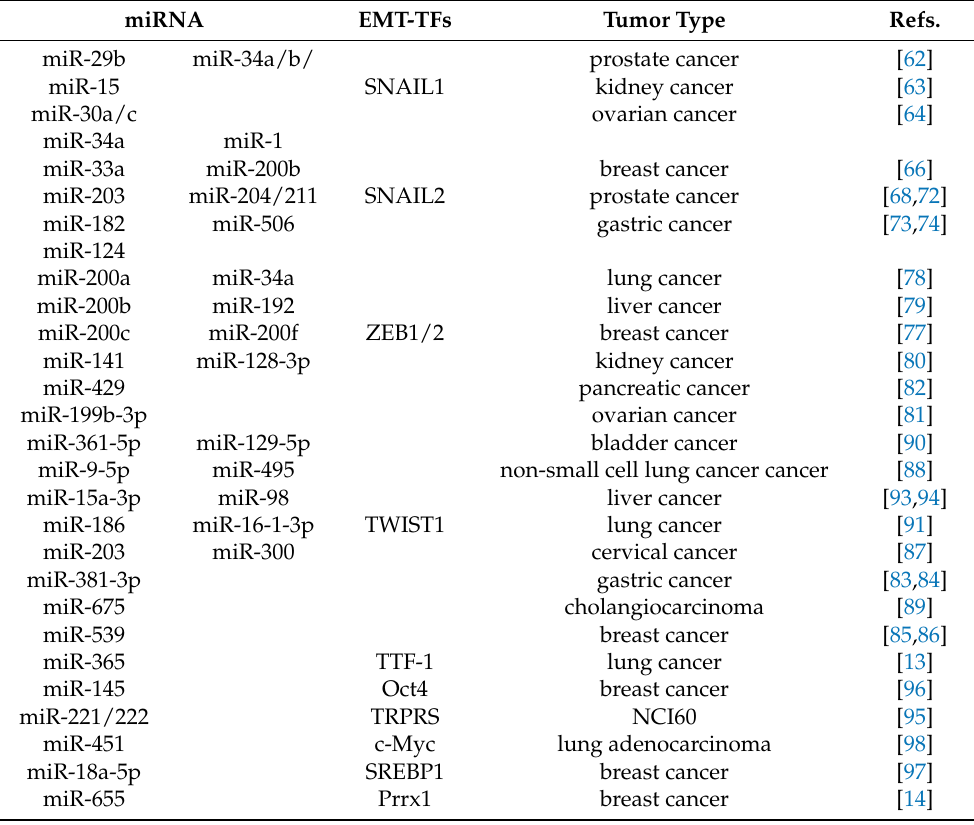
Table 1. Distinct miRNA-Targeted Transcription Factors to Regulate Tumor